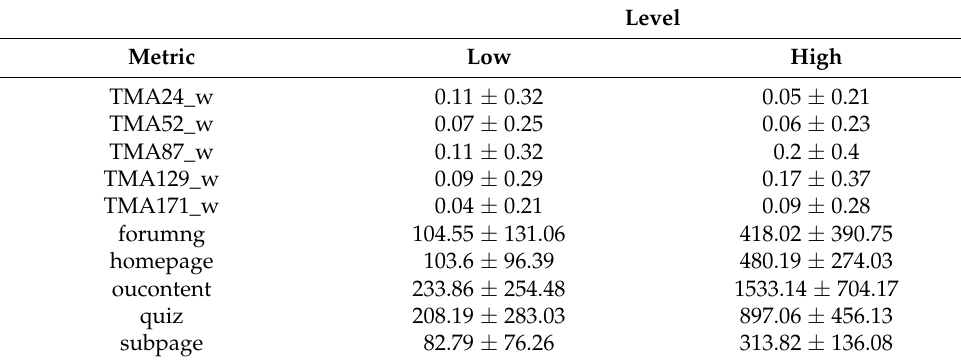
Table 2. Best clustering model centroids.